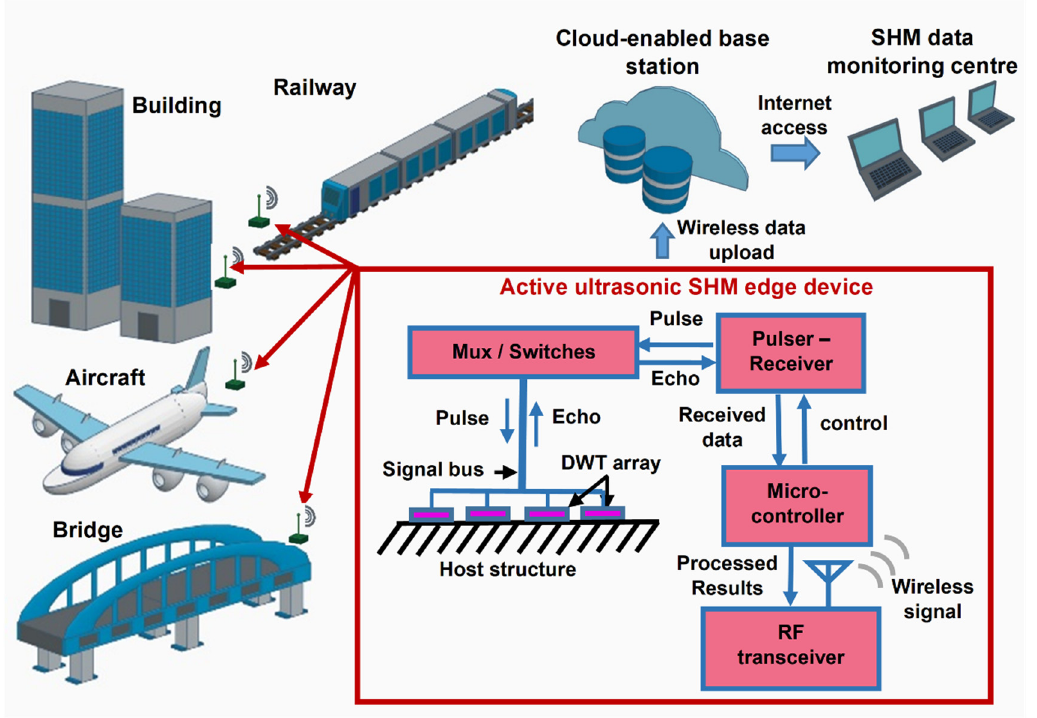
Figure 1. Conceptual illustration of the proposed active ultrasonic SHM edge computing system with DWT arrays in-situ fabricated on various kinds of host structures, scalable for Internet-of-things (IoTs) applications.